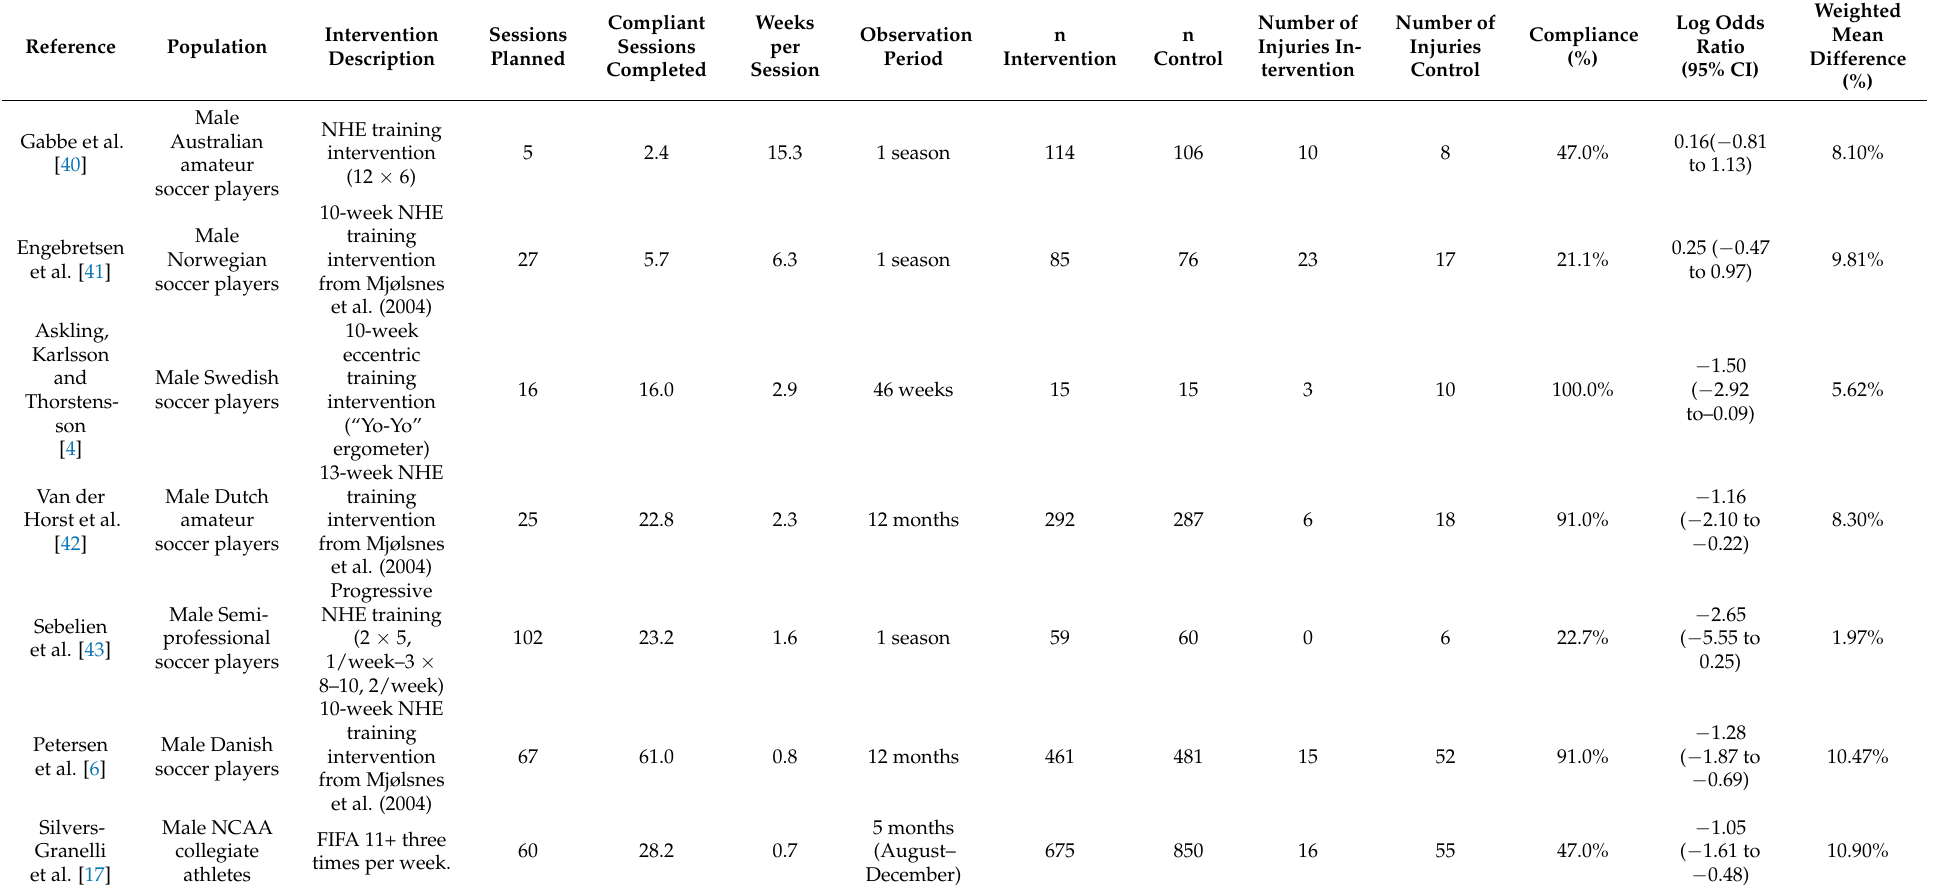
Table 2. Summary of athletes, interventions, comparators, percentage compliance and injuries of included